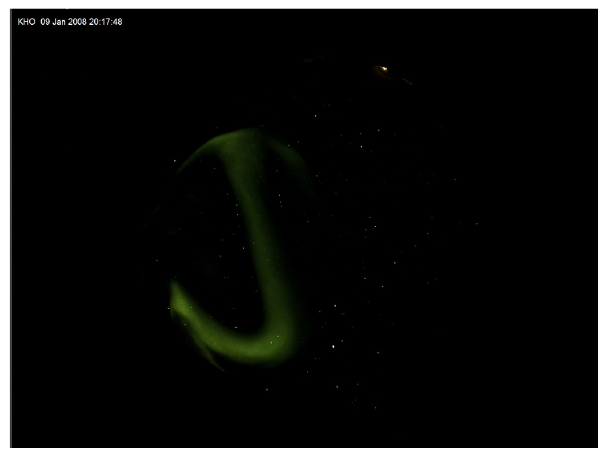
Fig. 1. UCL (Univerisity College London) all-sky camera, for 9 January 2008, 20:17UT. Northward direction is on the top of the image. Eastward on the